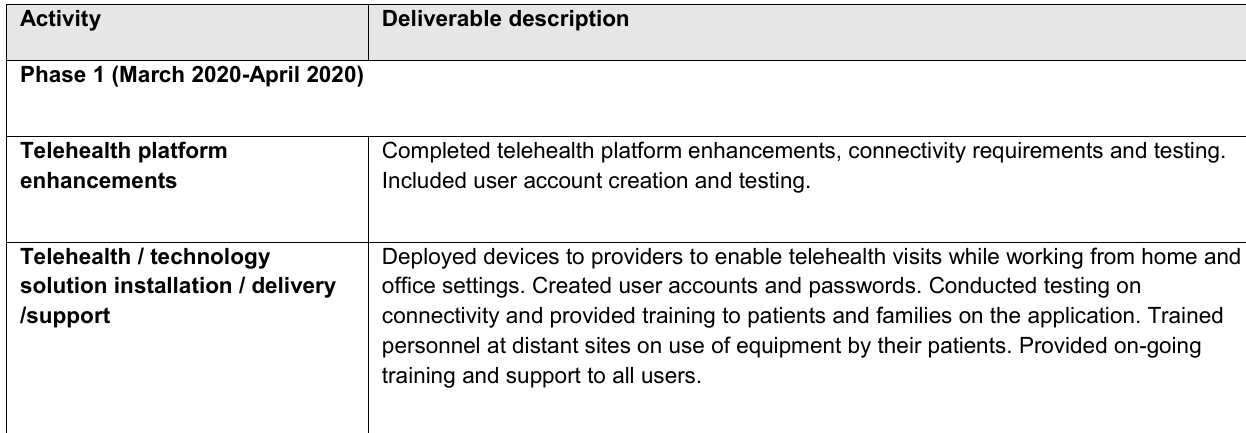
Operational Plan Activity Deliverable